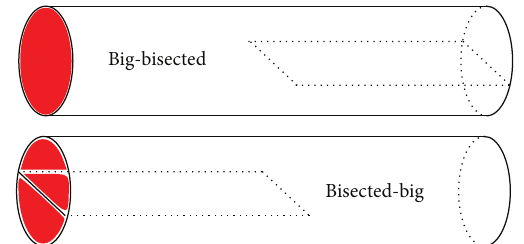
Figure 6: Geometries of pores based on half-cylindrical shapes (length: 1mm; diameter: 4𝐸 − 3 mm; red is the inlet